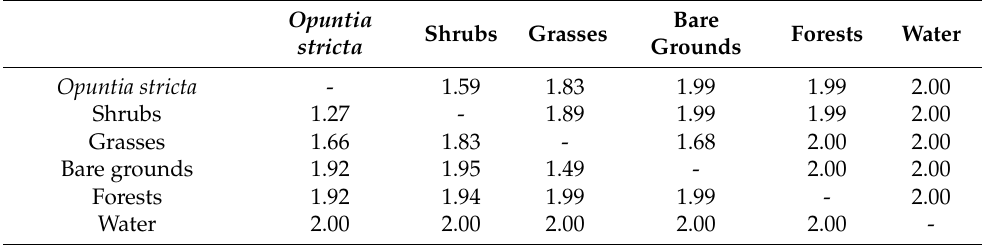
Table 4. Separable degree of Jeffries–Matusita (JM: bottom left diagonal) and transformed divergence (TD: upper right diagonal) between Opuntia stricta and other control classes based on Sentinel-2 imagery band. Opuntia Bare Forests Shrubs Grasses stricta Grounds